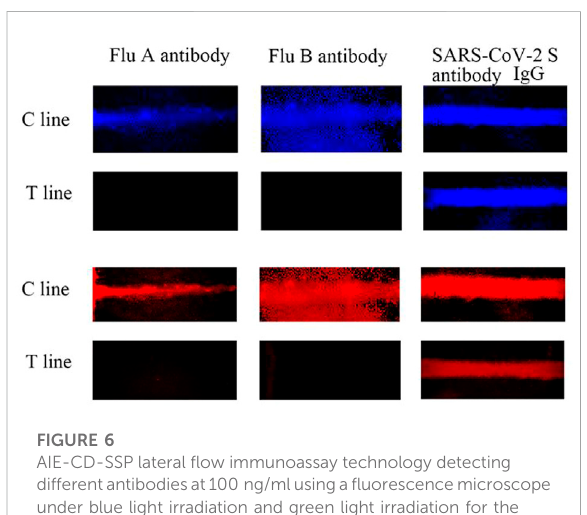
FIGURE 6 AIE-CD-SSP lateral fl ow immunoassay technology detecting differentantibodiesat100 ng/mlusinga fl uorescencemicroscope under blue light irradiation and green light irradiation for the selective